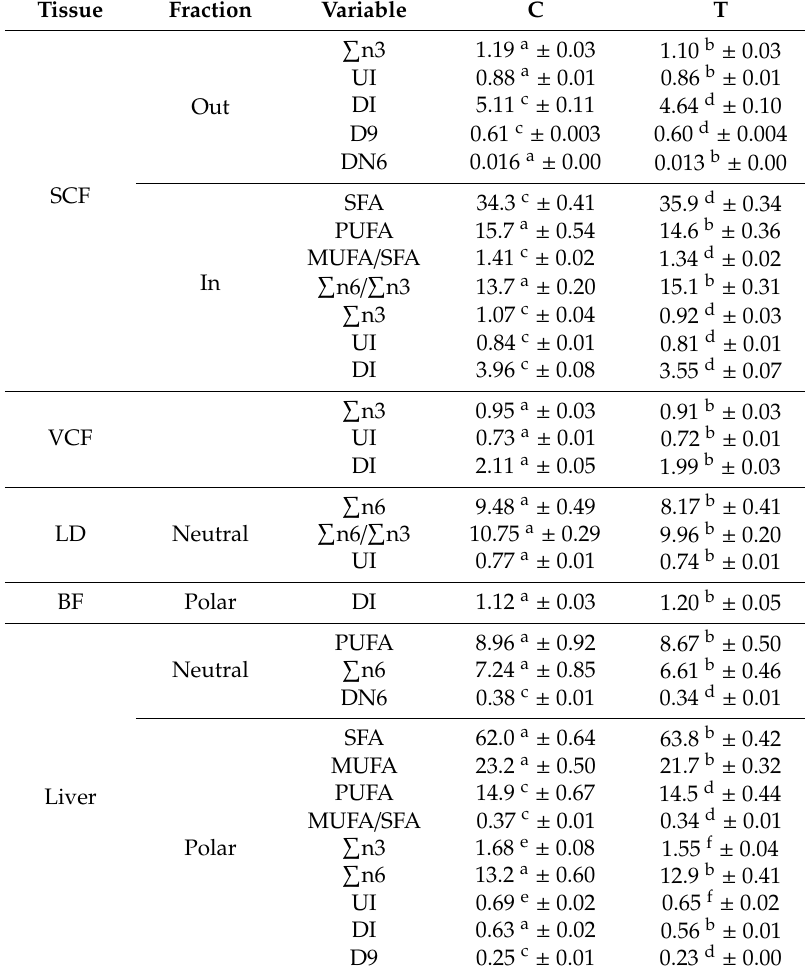
Table 5. Highlight of significant di ff erences ( p < 0.05) ± S.E.M. in fatty acid composition, at 180 days-old, between pigs born from sows treated or not with hydroxytyrosol and linseed oil during pregnancy (groups T, n = 20, and C, n = 17, respectively). Complete data are o ff ered in Supplementary Tables